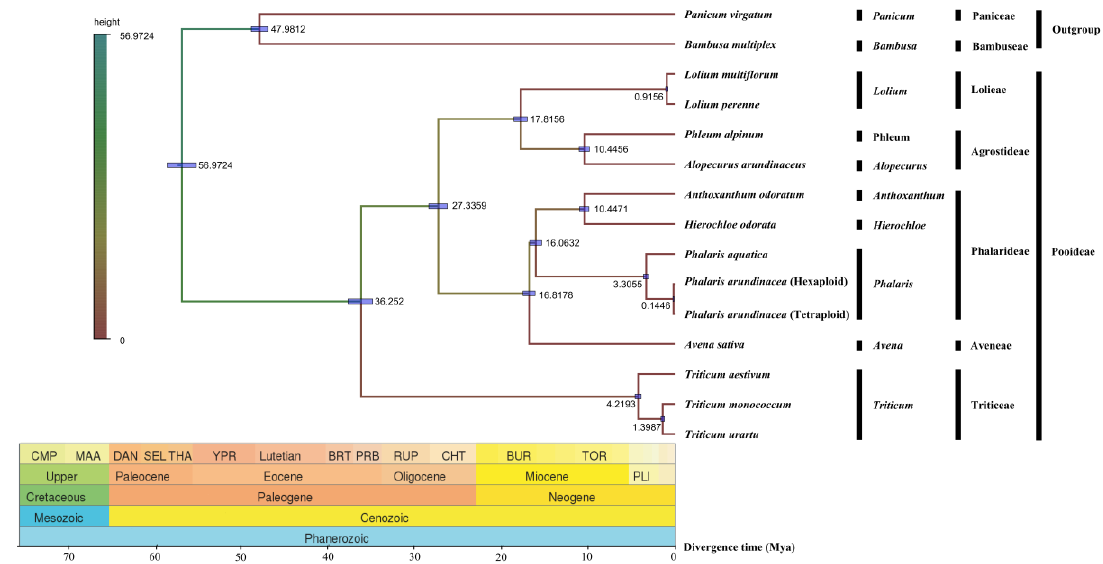
Figure 6. Divergence time among fifteen chloroplast genomes of seven tribes. Node values of the tree represent the average divergence time and blue bars of every node represent 95% credible interval.